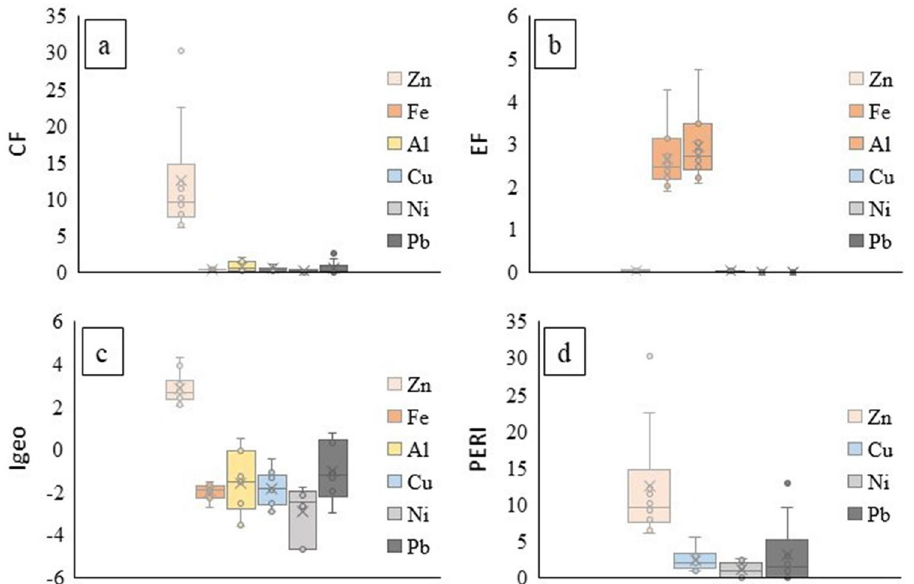
Figure 4. Soil indices assessed in the 10 urban sinkholes in the study in Cancun. ( a ) Contamination factor (CF), ( b ) enrichment factor (EF), ( c ) geoaccumulation index (I geo ) and ( d ) potential ecological risk index